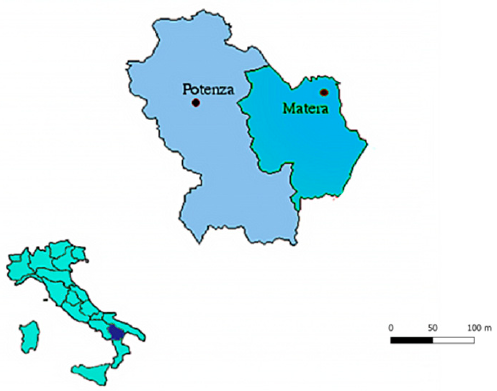
Figure 1. The Basilicata region in the South of Italy with a zoom on two provinces, Potenza and Matera.